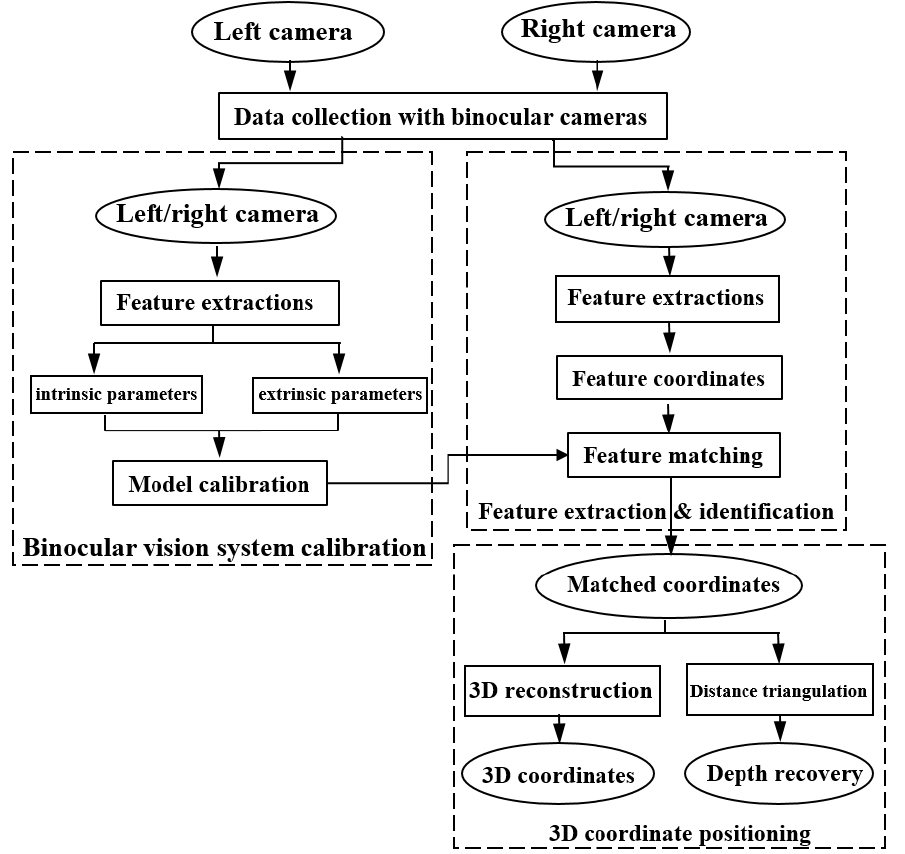
Figure 2. Working flow of the robot binocular vision